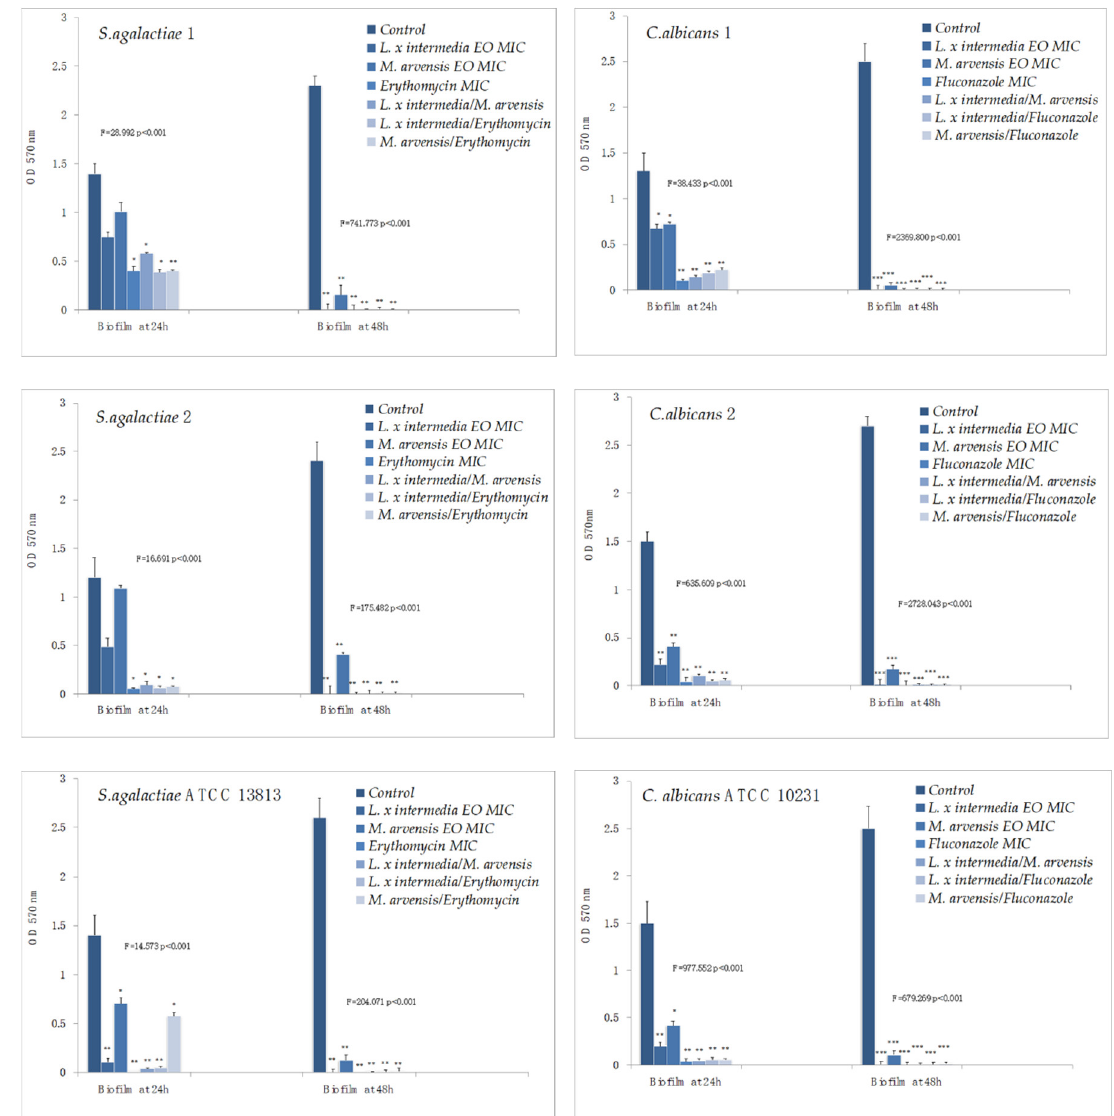
Figure 3. Anti-biofilm activity of L. x intermedia , M. arvensis EOs, antimicrobials (erythromycin and fluconazole), and of di ff erent combinations (antimicrobial / EO and EO / EO) against S. agalactiae and C. albicans strains. Results were expressed in optical density (OD) 570 nm as the arithmetic mean of the three determinations. p -values of < 0.05 (*), p < 0.01 (**), p < 0.001 (***) were considered significant by t -test and ANOVA.